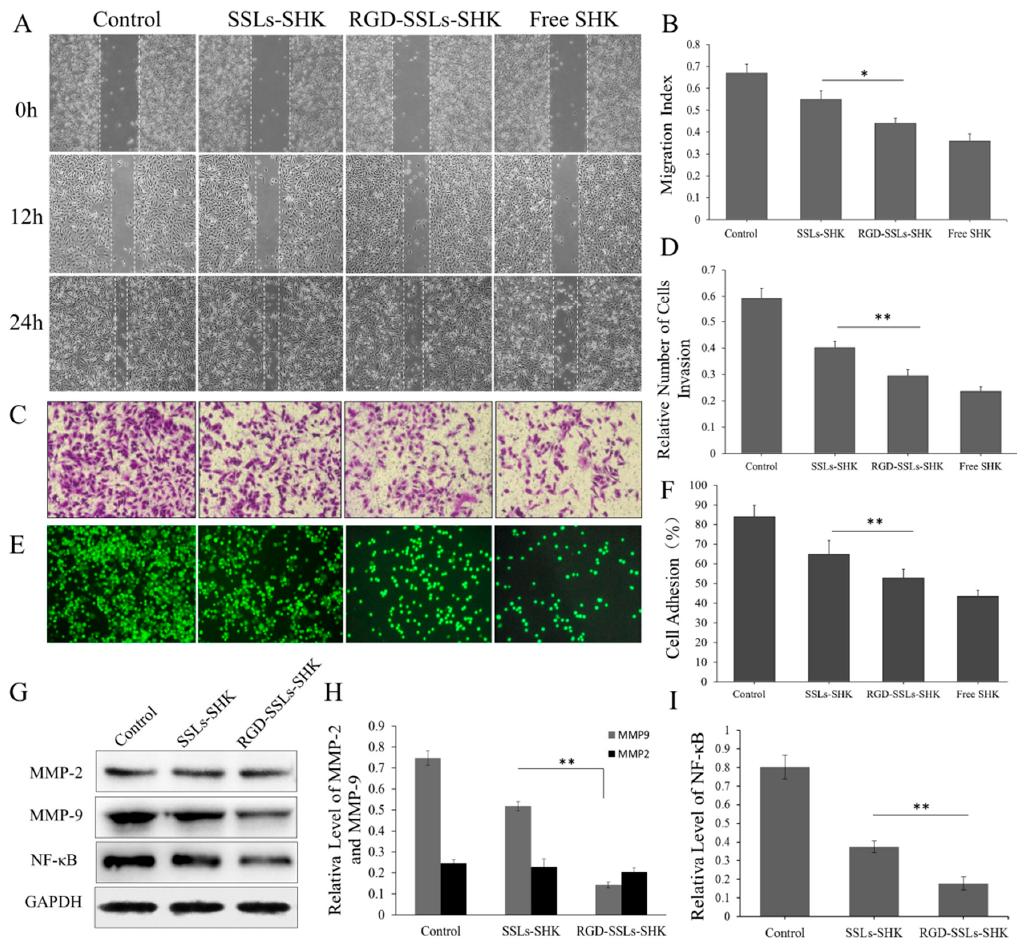
Figure 8. In vitro inhibitory effects of SSLs-SHK, RGD-SSLs-SHK, and free SHK on: migration ( A ); invasion ( C ); and adhesion ( E ) in the MDA-MB-231 by wound healing assay, Transwell invasion, and adhesion assay, respectively. Statistical analysis of: migration index ( B ); cell invasion ( D ); and cell adhesion ( F ) in the MDA-MB-231 cells; Western blot assay results of MMP-2, MMP-9, and NF- κ B p65 after the MDA-MB-231 cells was treated with SSLs-SHK and RGD-SSLs-SHK for 24 h ( G ). Analytic results of the band intensity values of: MMP-2 and MMP-9 ( H ); and NF- κ B p65 ( I ). * p < 0.05, ** p < 0.01.